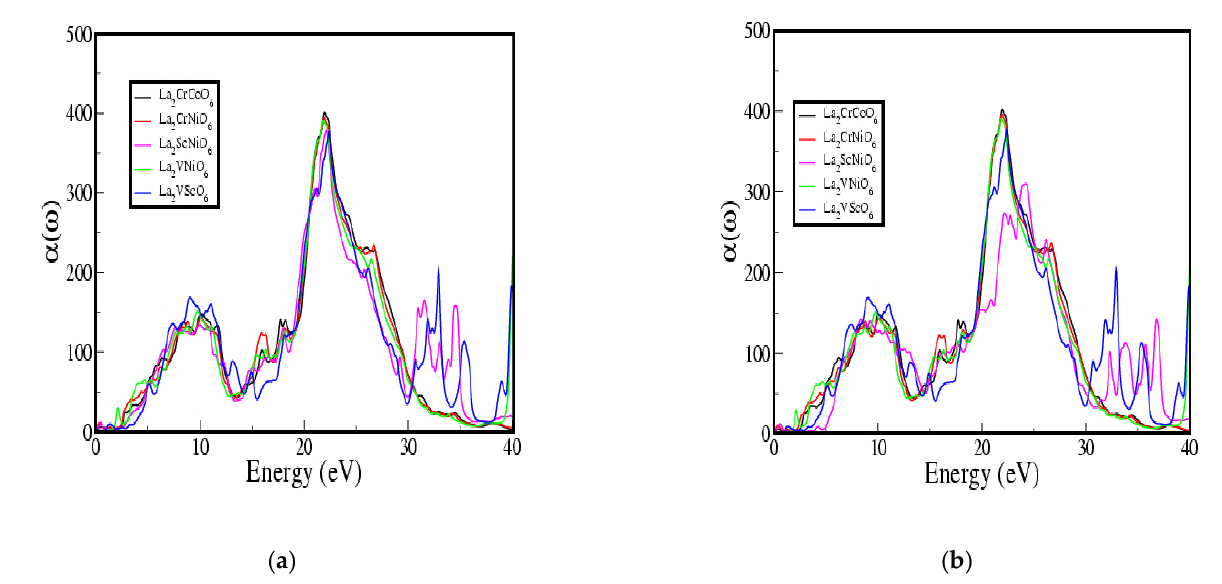
Figure 9. ( a ) Absorption coefficient of DPCs La 2 BB ′ O 6 using GGA and ( b ) using GGA+U. The absorption coefficient α ( ω ) of all the DPCs is plotted and the energy is taken from 0-40eV against α ( ω ). All compounds absorb wavelengths of energy when the energy increases from 1 eV. Within the visible energy limit, the La 2 VNiO 6 absorbs much